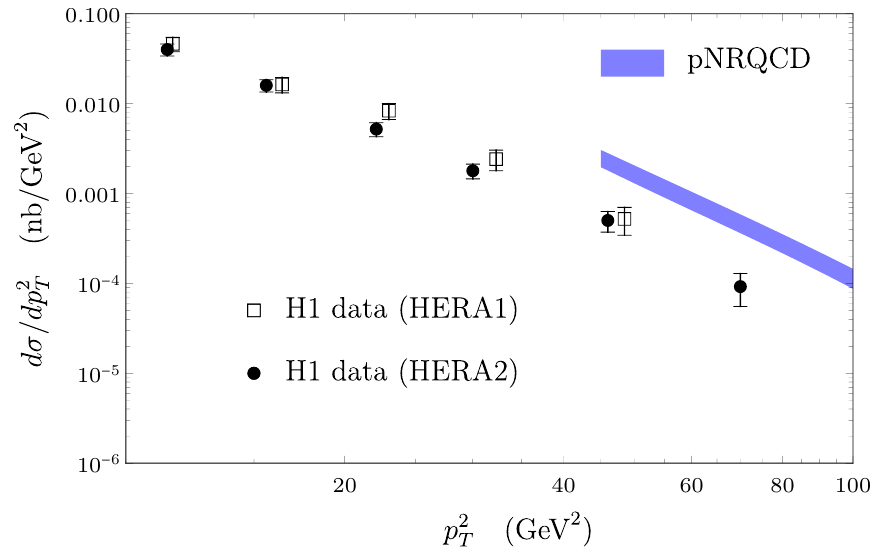
Figure 14 . Photoproduction cross section of J/ψ compared to H1 data [82,